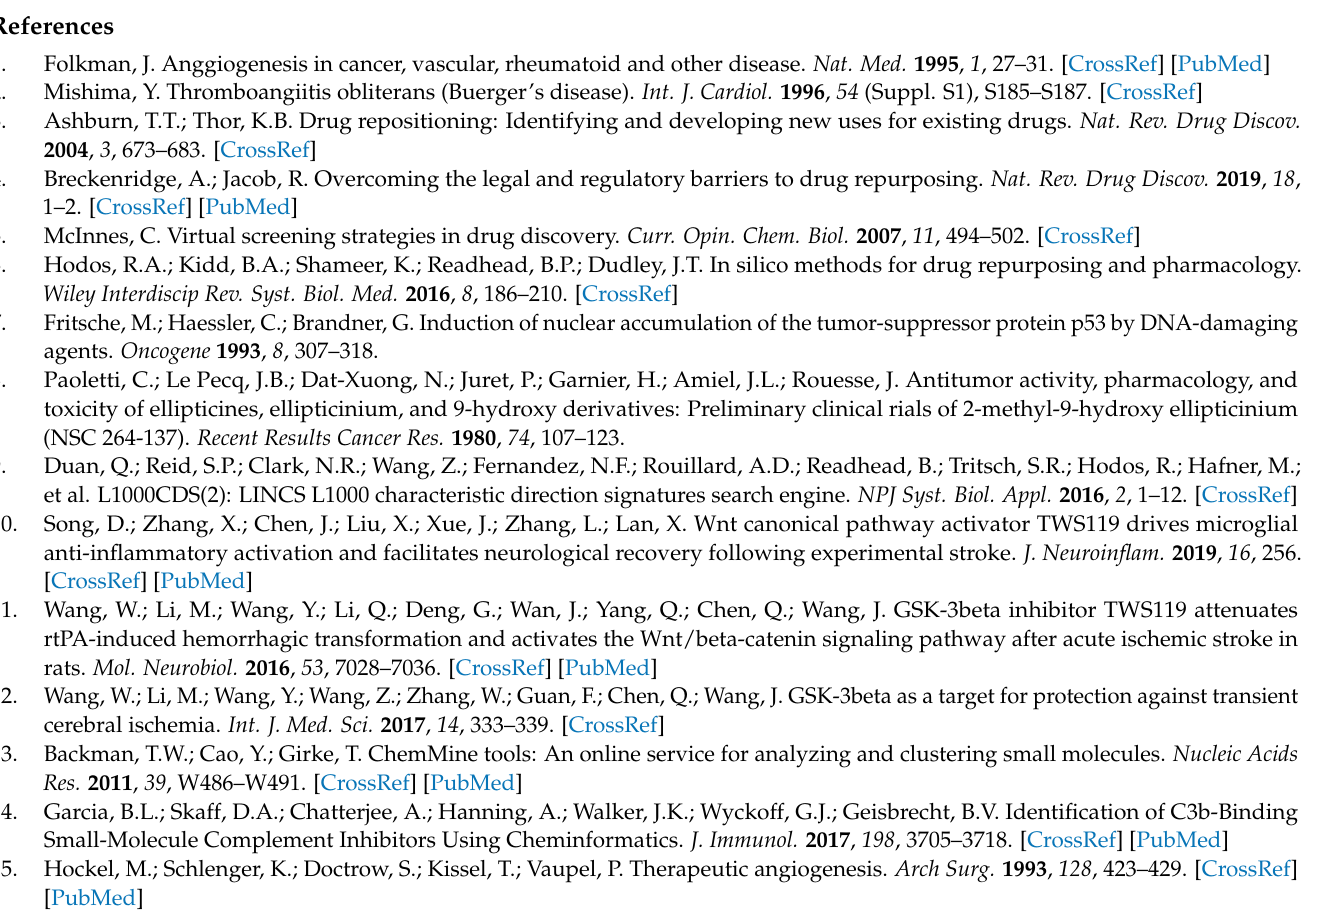
Supplementary Materials: Table S1: Reverse or mimic DEG signatures for the candidate compounds. Table S1 will be available at